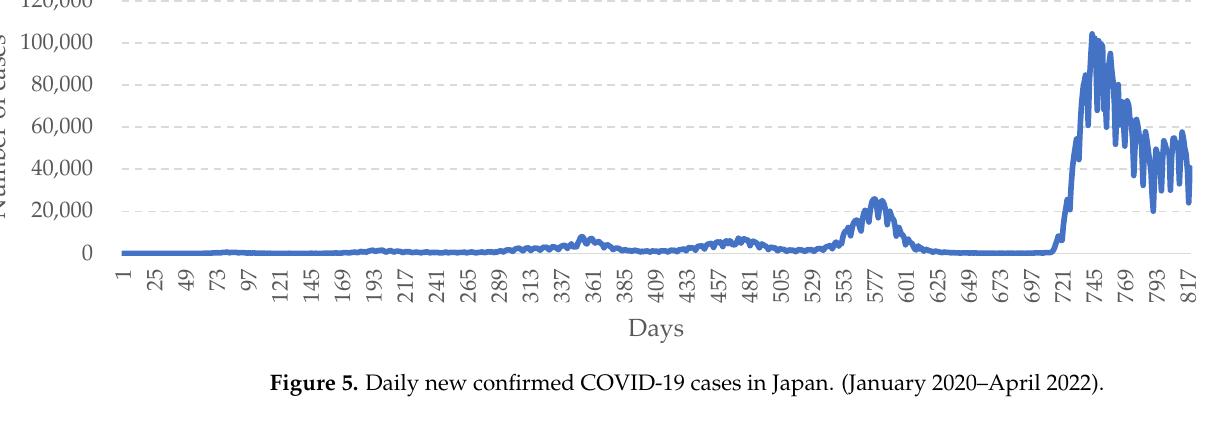
Figure 6. Daily death rate in Japan. (January 2020–April 2022). When a pandemic begins to spread in large numbers (such as COVID-19), govern- ments are most concerned about the rapid rise in confirmed cases. In the post-epidemic era, governments would pay particular attention to issues relating to the reduction of the mortality rate, including the treatment of severe cases and how to provide effective treat- ments. Therefore, this study uses the death rate as an important evaluation index and classifies the epidemic situation into different alert states as a reference for healthcare pol- icy makers. The dataset comprises 819 days of COVID-19 data in Japan. We defined death rates for a daily number equivalent to or below 0.005 as low death rates (I), death rates between 0.005 and 0.01 as mid death rates (II), and death rates equivalent to or above 0.01 as high death rates (III). In the dataset, 83 cases were classified into the low death rate level (I), 34 cases into the mid death rate level (II), and 702 cases into the high death rate level (III). Death rate is defined as follows: